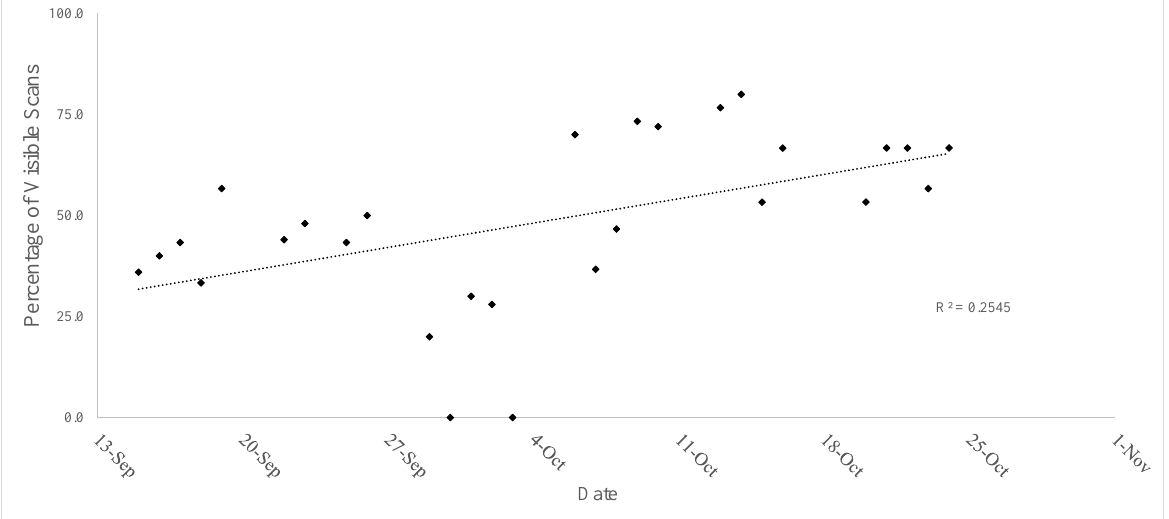
Figure 1 . Weekly average foraging and activity levels throughout the study.